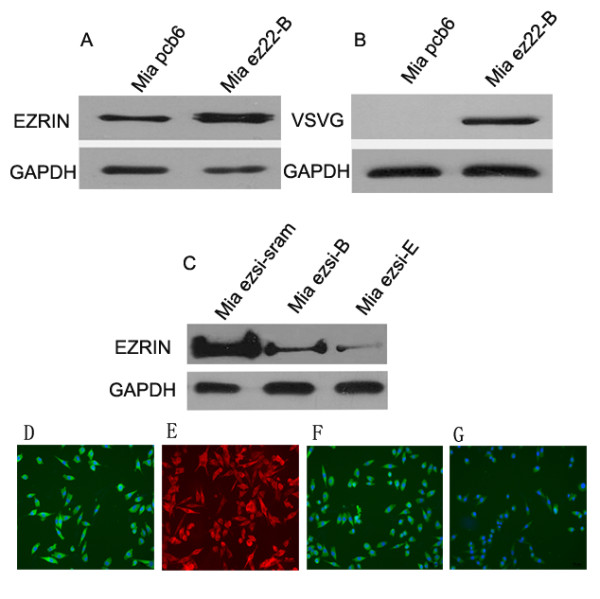
Stable overexpression and silencing of ezrin in MiaPaCa-2 cells. (A) Western blot showed the ezrin protein was overexpressed in the Mia ez22-B cells compared to the Mia pcb6 cells using an ezrin antibody. The relative ezrin protein level was quantified by densitometry analysis. The ezrin protein was efficiently increased by 3.8 folds in the Mia ez22-B cells. (B) Ectopic expression of ezrin in the Mia ez22-B cells was detected using a VSV-G antibody (VSV-G tag in the pcb6-ezrin vector). (C) The expression level of ezrin protein was dramatically decreased by 70.5% and 90.1% in the Mia ezsi-B and the Mia ezsi-E cells, respectively, compared to that in the Mia ezsi-scram cells. GAPDH was used as a loading control. (D) The Mia pcb6 cells were stained with the ezrin antibody and a FITC-conjugated second antibody to detect the ezrin protein expression. (E) The vector tag VSV-G antibody and a Rhodamine-conjugated second antibody were used to detect the exogenous ezrin protein expression. (F, G) The Mia ezsi-scram and the Mia ezsi-E cells were stained with the ezrin antibody and the FITC-conjugated second antibody to detect the ezrin protein expression.